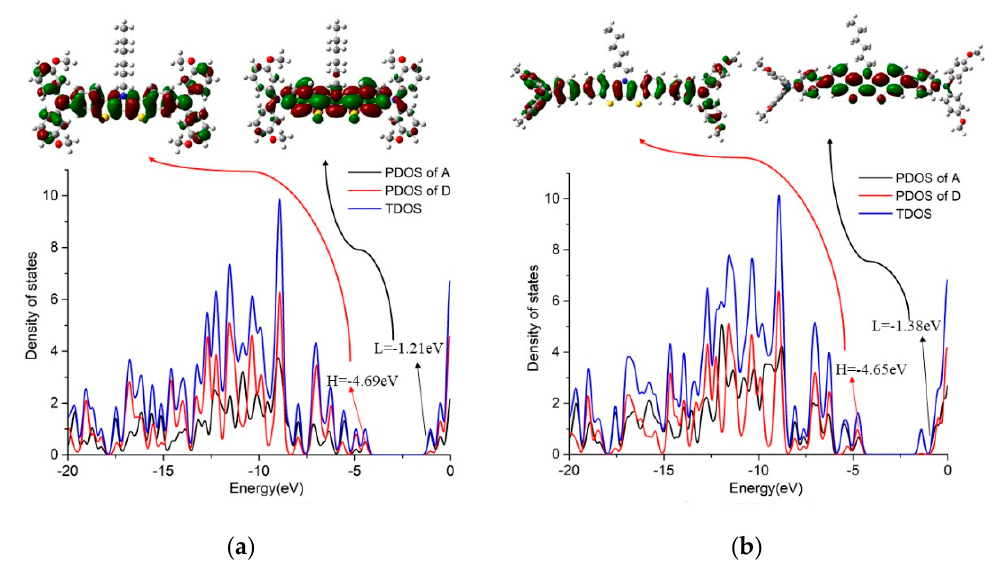
Figure 2. The partial density of states (PDOS) of the fragment A and D, where ( a ) mDPA-DBTP and ( b ) pTPA-DBTP.